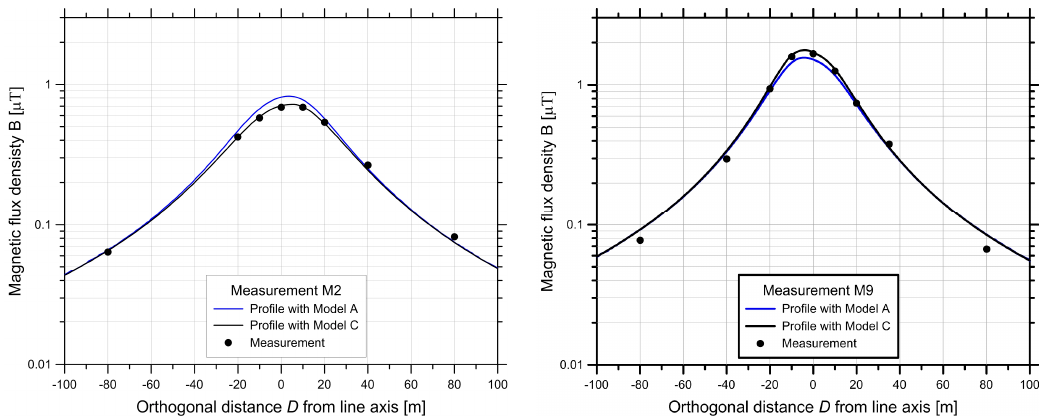
Figure 12. Comparison of the modelled lateral profiles for two measurements. ( Left ) M2 in Wiler; ( Right ) M9 in Iffwil. The dots are the measurements, and the lines are the calculated values for two different numerical height models: Model A uses the DHM25 (blue curves), Model C uses the more precise DHM5 (black curves).